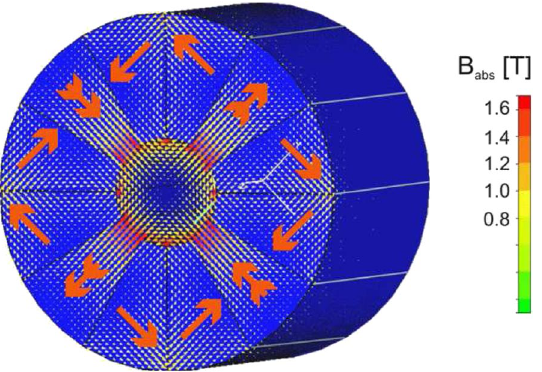
FIG. 8. (Color) Schematic view of the 12 segment Halbach design of one quadrupole magnet. While 4 radially magnetized segments define the quadrupole field, 8 are used for the outer field closure, thick arrows indicating the direction of magneti- zation. False color arrows illustrate the simulated strength and direction of the resulting quadrupole field inside a bore of radius (cid:1) 3 mm . The tip field strength amounts to B (cid:9) r r i